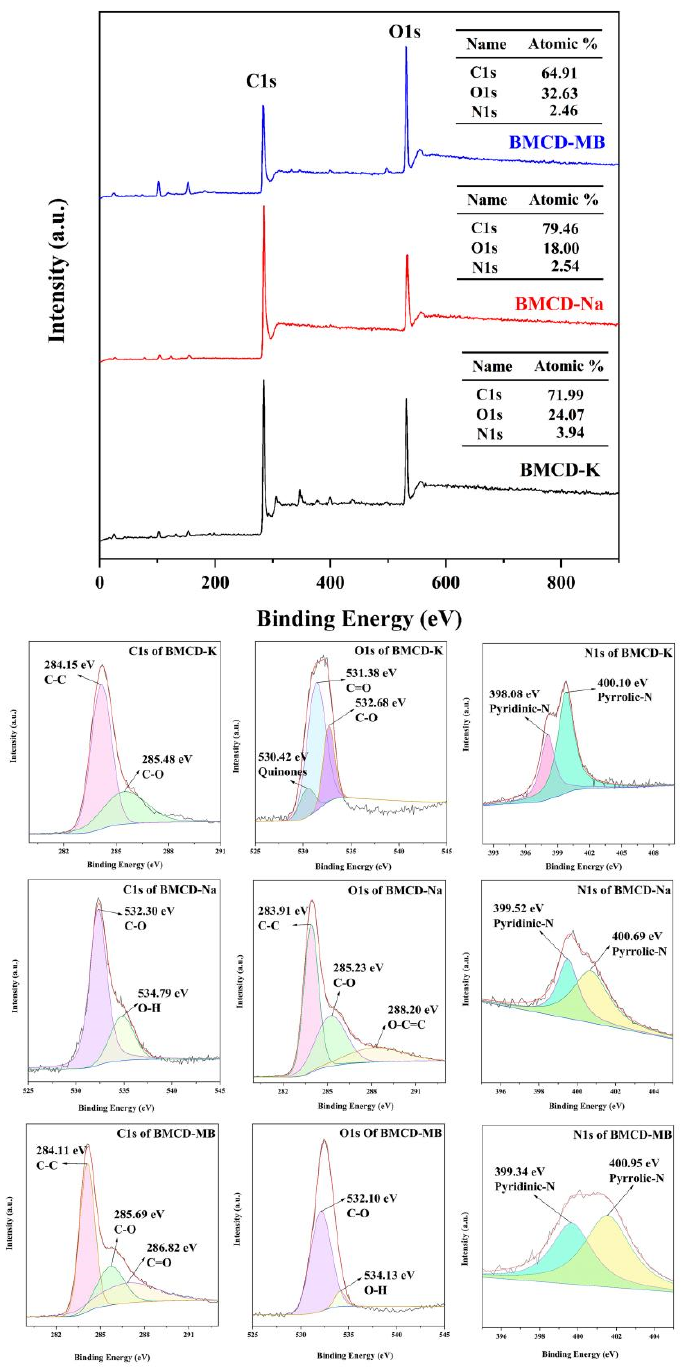
Figure 4. XPS spectra and the C1s, O1s, N1s of BMCD-K, BMCD-Na, and BMCD-MB. Zeta potential test was used to evaluate the surface charges of BMCDs, and the results were shown as Figure 5. When pH changes from 2 to 10, the surface charges of BMCDs changes from positive (21.3, 17.3, and 17.6 for BMCD-MB, BMCD-K, and BMCD-Na) to negative ( − 32.4, − 34.1, and − 33.5 for BMCD-MB, BMCD-K, and BMCD-Na). Variable surface and constant charges determine the point at which the charge is zero, often